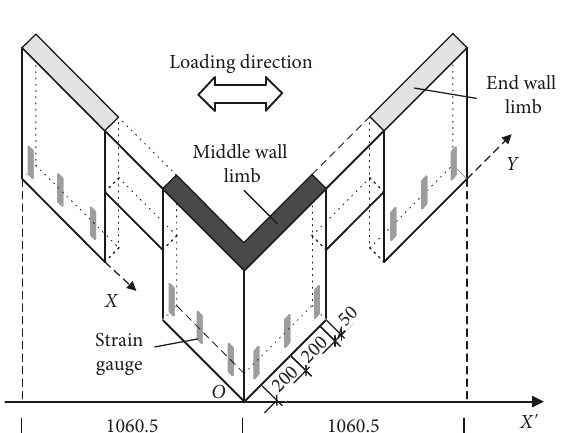
Figure 3: Test setup.